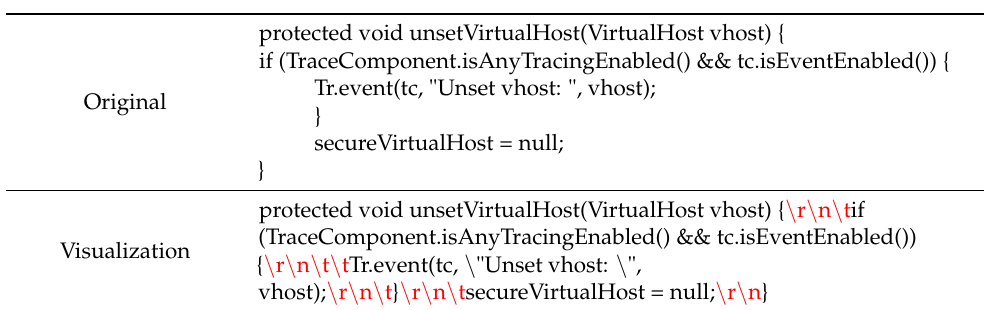
Table 4. Original and visual format of the code.